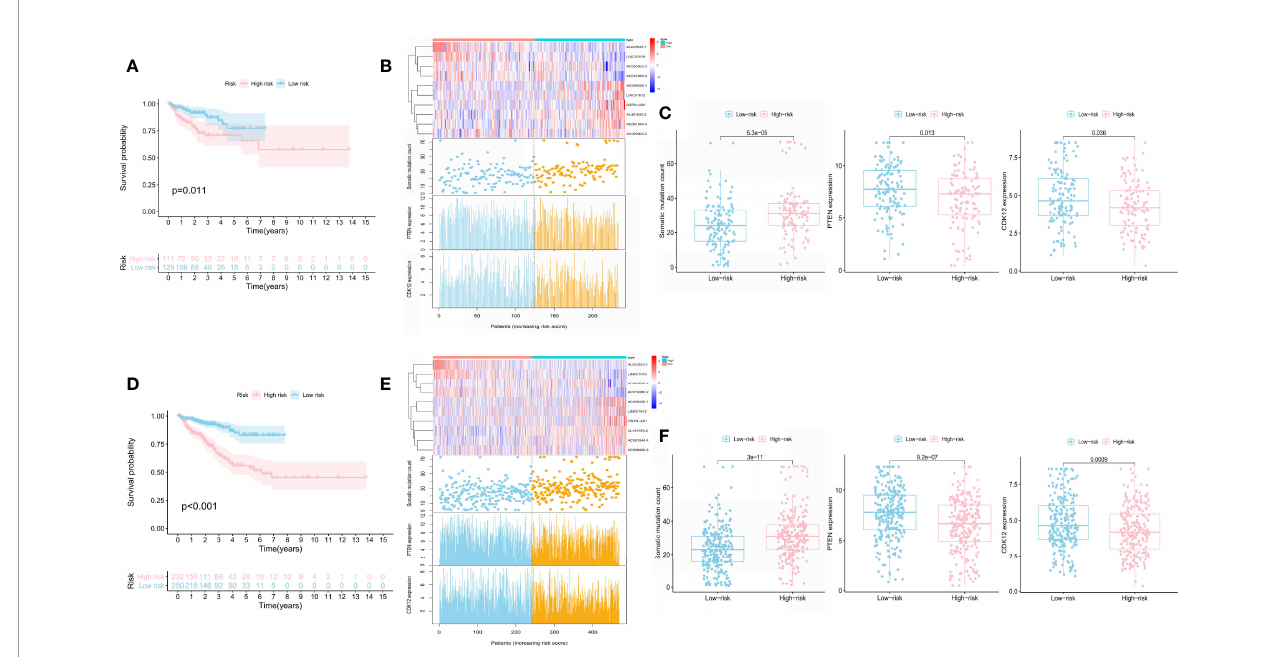
FIGURE 4 | Prognostic performance of the GILncSig in the test set and the whole TCGA set. Kaplan – Meier analysis of biochemical recurrence in patients with low or high risk predicted by the GILncSig in the test set (A) and the TCGA set (D) . lncRNA expression pro fi les, somatic mutation count distribution, and PTEN and CDK12 expression for patients in the high- and low-risk groups in the test set (B) and the TCGA set (E) . Somatic mutation distribution and PTEN and CDK12 expression for patients in the high- and low-risk groups in the test set (C) and the TCGA set (F) .